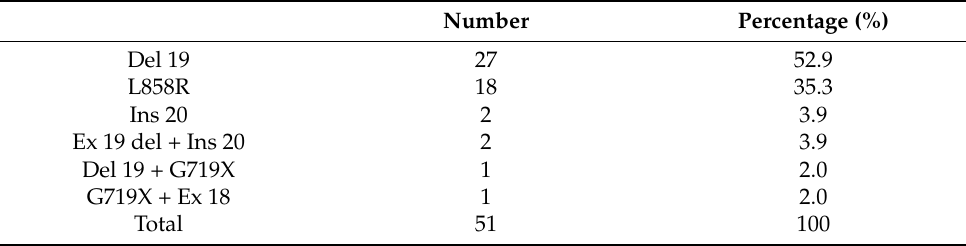
Table 2. EGFR status of resected tumor tissue as determined using the Therascreen assay.